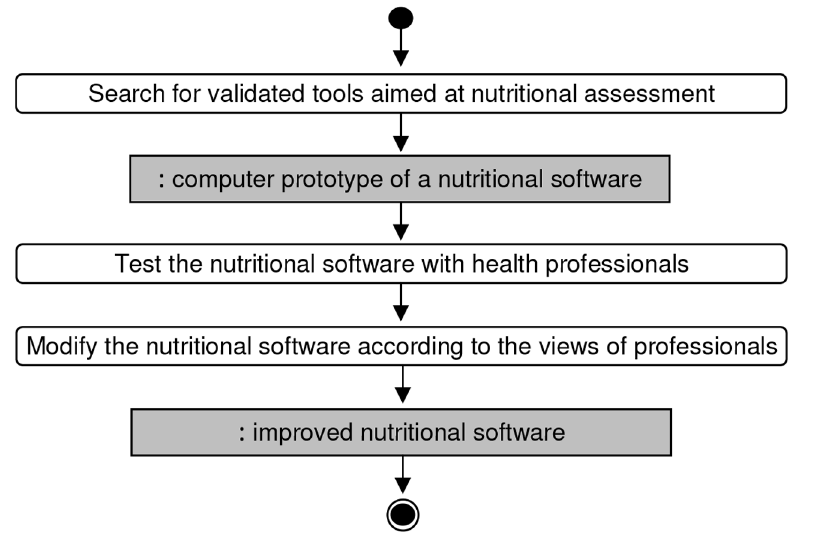
Fig 5. Activity Diagram for the First Phase of the assessment of the